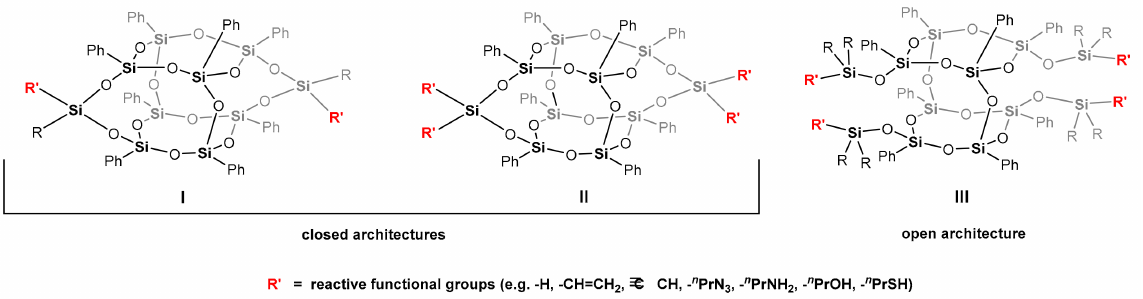
Figure 3. Types of double-decker silsesquioxanes: closed architectures ( I , II ) and open architecture ( III